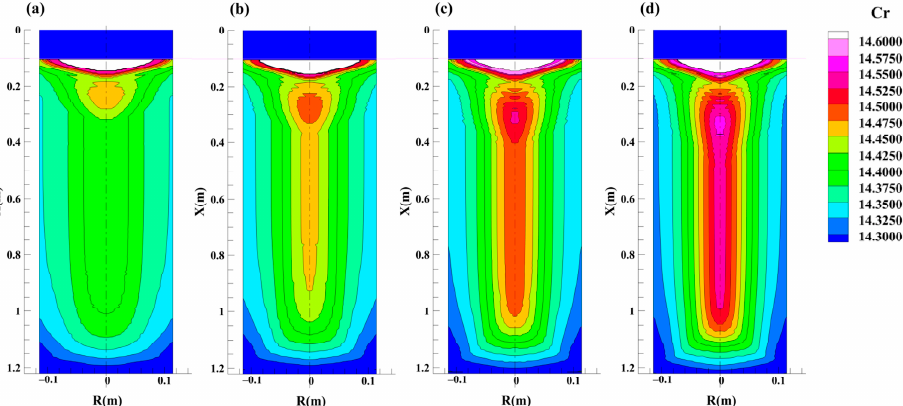
Figure 17. Distribution of C concentration at varying melting rate: ( a ) 90 kg/h, ( b ) 120 kg/h, ( c ) 150 kg/h and ( d ) 180 kg/h.